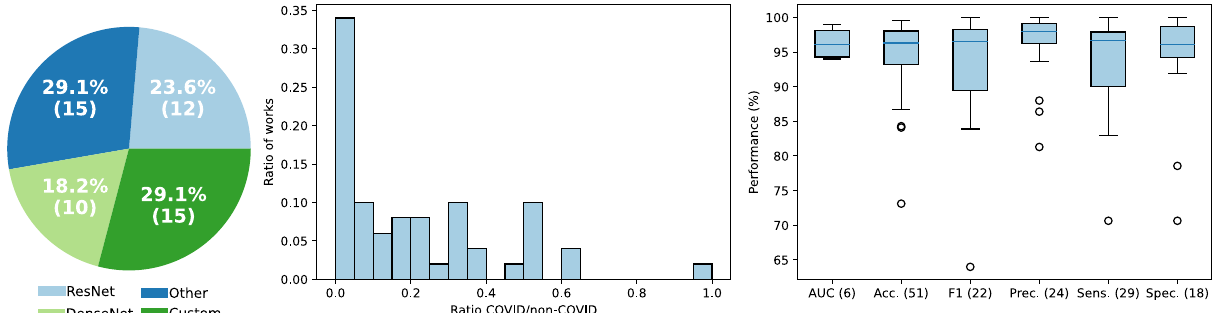
Figure 1. Summary of the types of deep learning architecture (left), ratio of studied COVID-19 CXRs (center) and performance of automatic COVID-19 diagnosis in CXR up to July 2020 (right). Performance metrics: AUC - area under the ROC curve; Acc. - accuracy; F1 - F1 score; Prec. - precision; Sens. - sensitivity; Spec. - specificity (number of